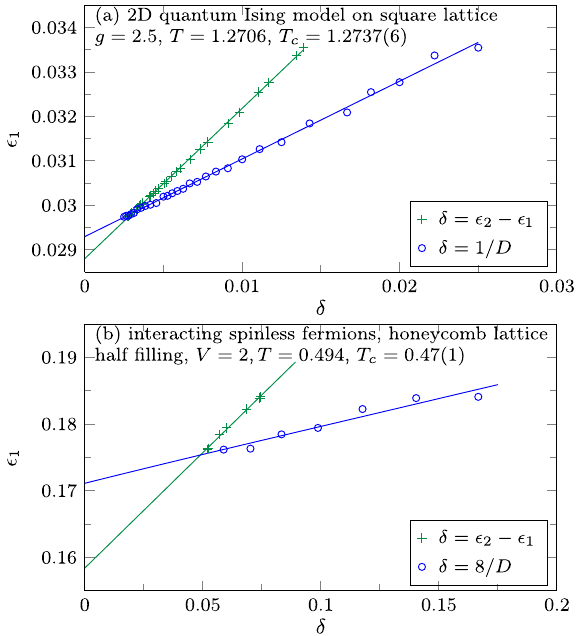
FIG. 9. Two-dimensional quantum systems at finite temper- ature. PEPS description was obtained with VTNR algorithm [62 – 64]. (a) Results for quantum Ising model on a square lattice with PEPS bond dimension χ ¼ 5 2 — with square accounting for double layer of PEPS tensors. (b) Results for interacting spinless fermions on a honeycomb lattice ( χ ¼ 16 2 ). In panel (a), CTM bond dimension was D ¼ 40 – 400 and D ¼ 50 – 140 in (b). In both cases ϵ 1 ð D Þ is approaching an asymptotic value nearly linearly as a function of the refinement parameter δ ¼ ϵ 2 − ϵ 1 introduced in this article. Using 1 =D as a refinement parameter results in less trustworthy extrapolation with an error of a few percent. The values of T , which we show for reference, were c obtained from Monte Carlo simulations [65]. (a) 2D quantum Ising model g ¼ 2 . 5 , T ¼ 1 . 2706 , 1 . 2737 ð 6 Þ , (b) interacting spinless fermions, honeycomb T c ¼ 0 . 47 ð 1 Þ lattice, half-filling, V ¼ 2 , T ¼ 0 . 494 , T c ¼